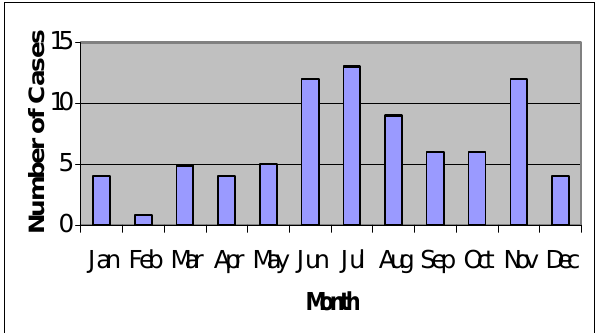
Figure 3: Average annual cases of E.coli O157:H7 by seasonal distribution for the years 1996 - 2001 in Louisiana (LDHH